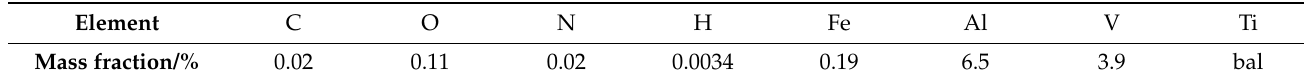
Table 1. Chemical composition of Ti6Al4V powder.